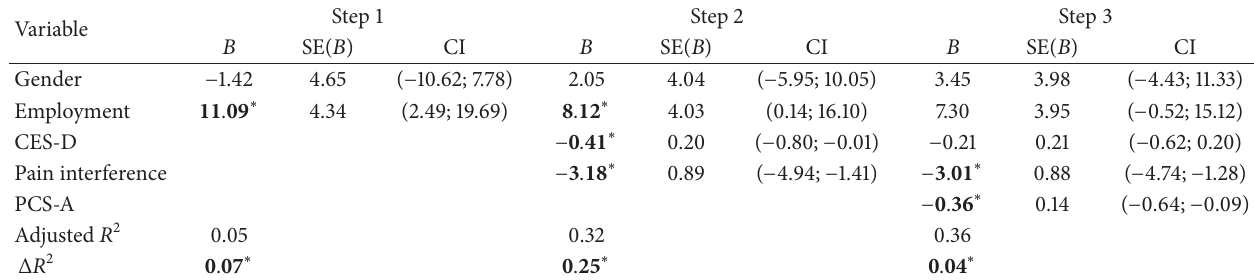
Table 3: Summary of hierarchical regression analysis for PCS-A predicting quality of life